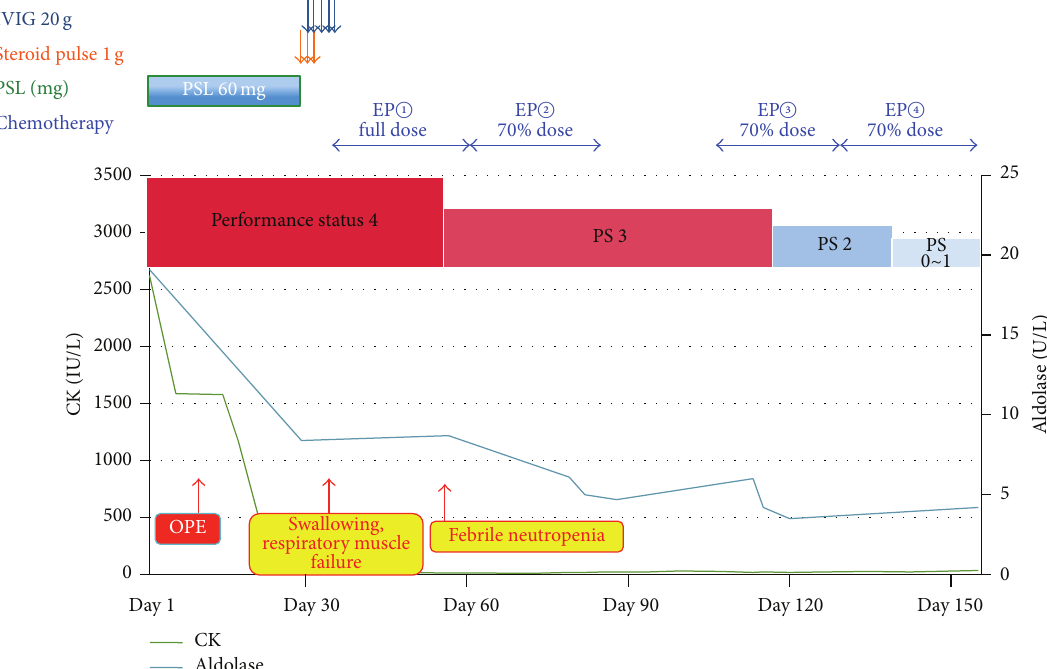
Figure3:Clinicalcourseofthepatient.Afterorchiectomyandconventionalimmunotherapyfordermatomyositis,PSremainedlow(PSgrade 4) and levels of myogenic enzymes were not fully normalized. We then started four courses of EP regimen, and at the time of completion, PS had improved to grade 0 or 1, and MMT became